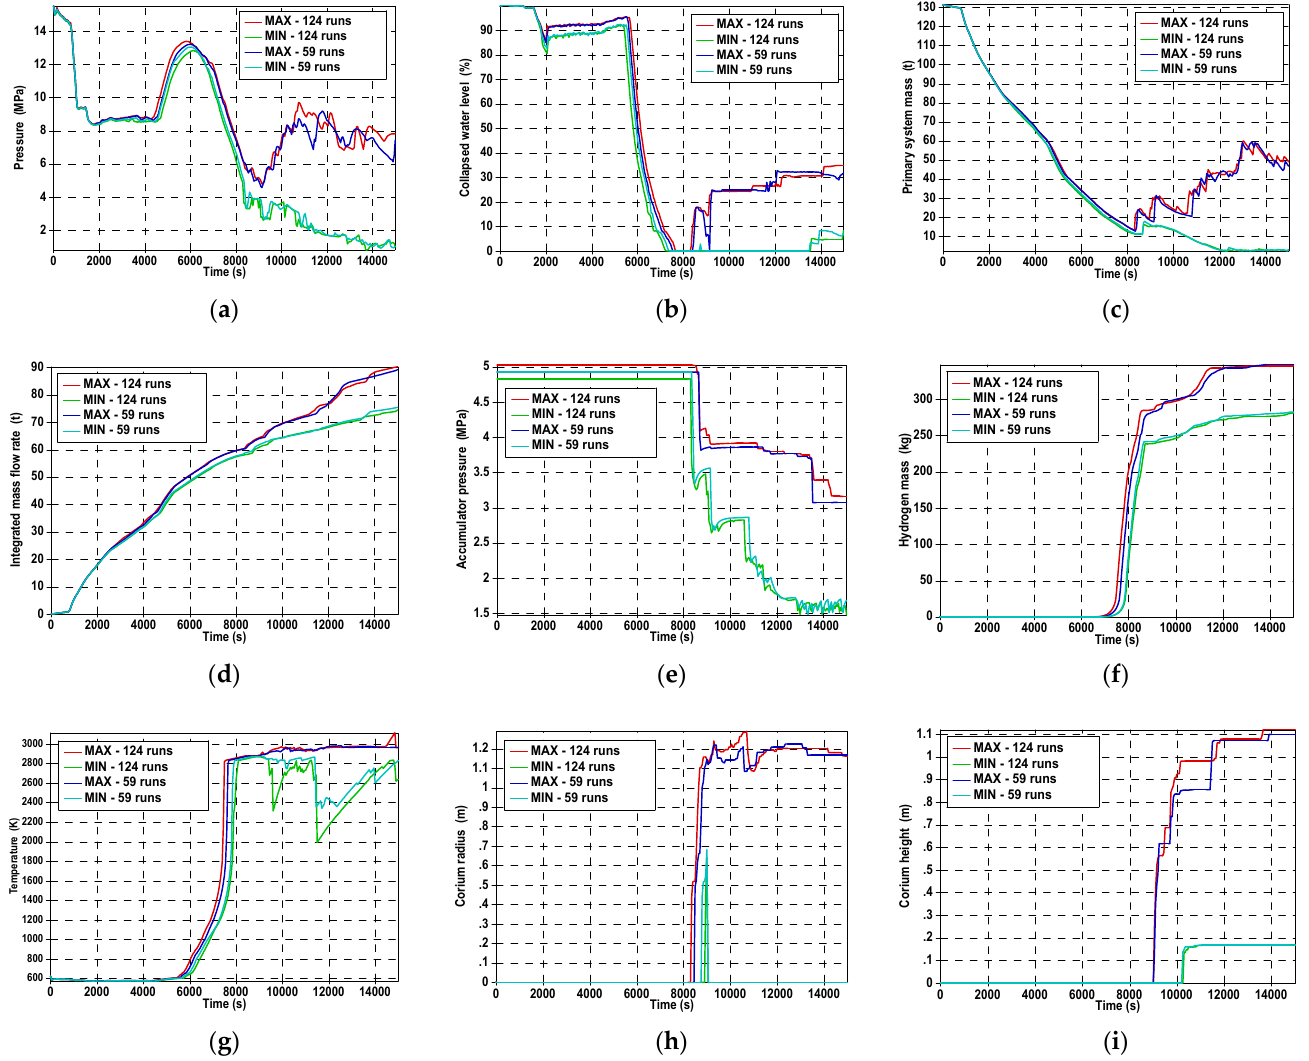
Figure 16. Bounding values of output variables for 59 and 124 calculations: ( a ) Pressurizer pressure; ( b ) collapsed water level in the core; ( c ) primary system mass; ( d ) integral mass flow rate at the break (loop 1); ( e ) accumulator pressure; ( f ) production of hydrogen; ( g ) maximum core temperature; ( h ) radius of the in-core molten pool; ( i ) corium height in the lower head. Table 2. Relative standard deviations and coefficients of range for output variables, mean and max- Dispersion of results is determined using the relative standard deviation and the imum values. coefficient of range. Mean and maximum values of relative standard deviations and coefficients of range of output variables are shown in Table 2. The numbers in parentheses indicate the number of performed calculations. The coefficient of range is defined as the ratio of difference between the highest and the lowest value of a variable to their sum, ( x max − x min )/( x max + x min ). Thus, this coefficient takes into account only minimum and maximum values, regardless of the dispersion of other